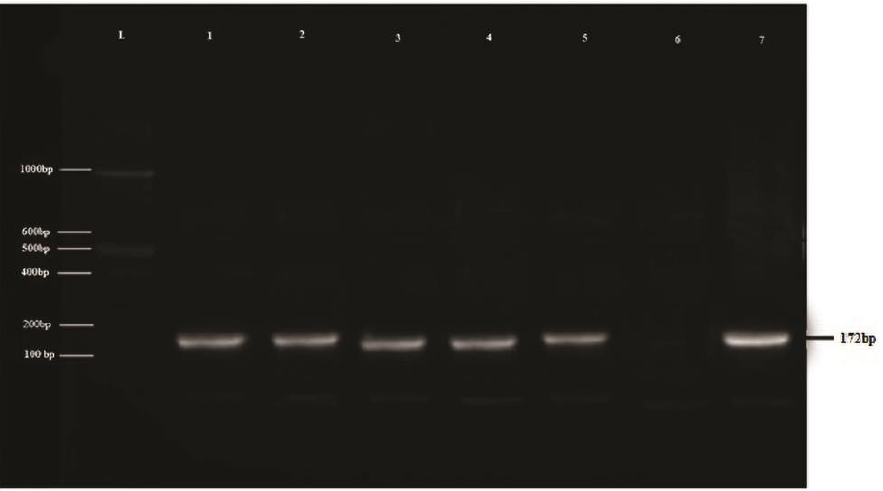
Figure 1. Agarose gel electrophoresis pattern of RPO30 gene-based PCR assay for detection of LSDV. L: molecular ladder marker of 100 bp; lanes 1–5: 172-bp RPO30 gene-amplified PCR products from field samples; lane 6: negative control; lane 7: positive